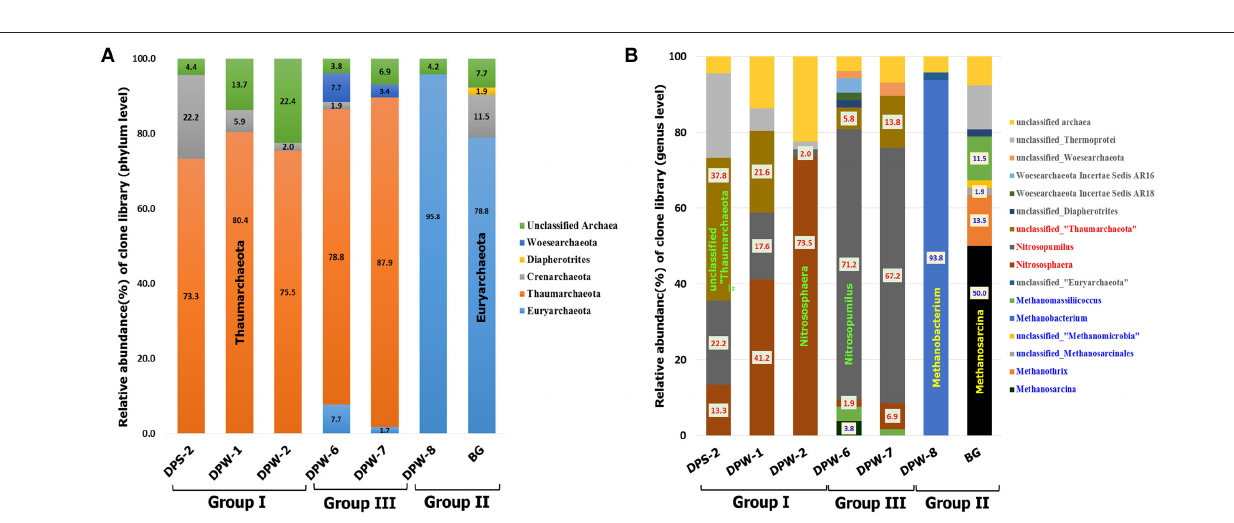
suggests that the methane in samples from each site may have been generated by different methanogenic pathways.